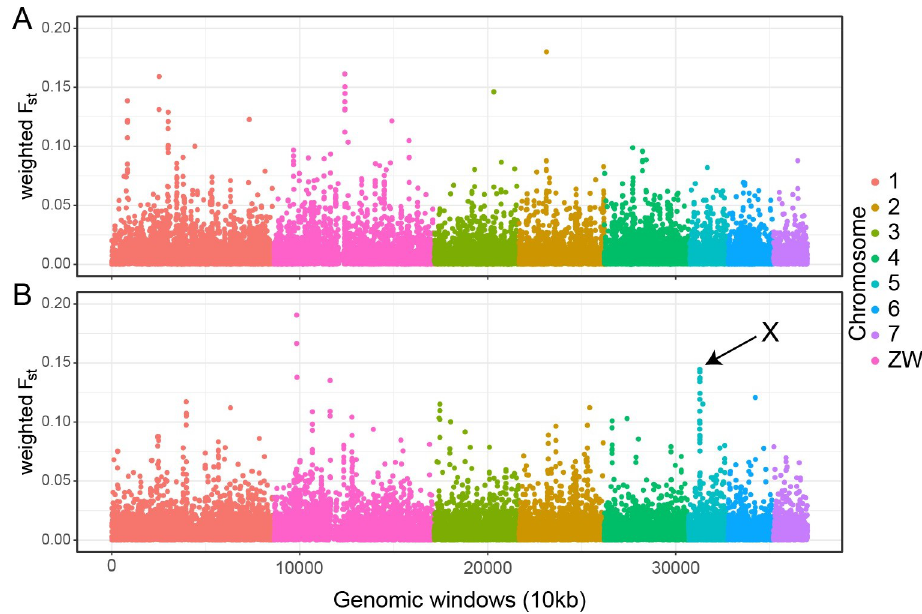
Fig 5. Genome-wide genetic differentiation between standard and intensive populations. F ST calculated using pre-treatment (A) and post-treatment (B) samples. X marks the region of high post-treatment genetic differentiation discussed in the text. Each point represents the mean F ST between genomic windows of 10 kb for all the called SNPs, with different coloured points representing SNPs on each chromosome.